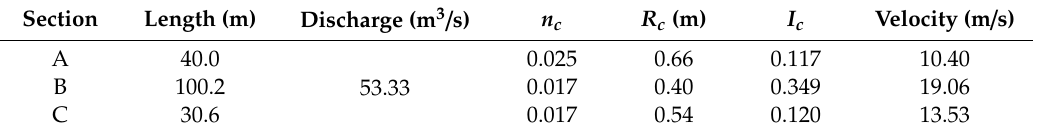
Table 3. Segmented design parameters of Xiaogangjian drainage